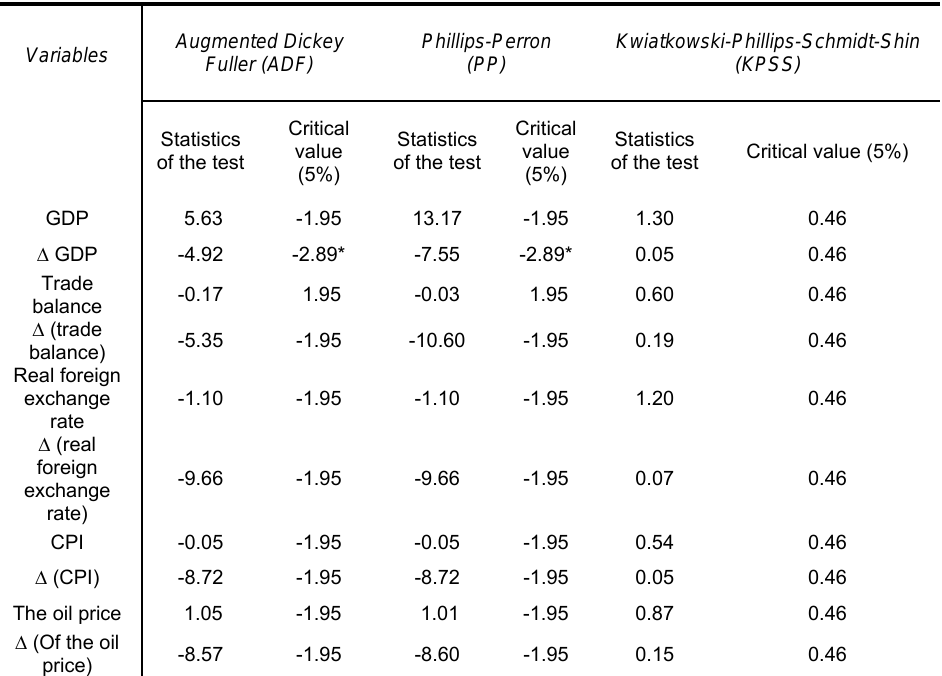
Table 1. Unit root